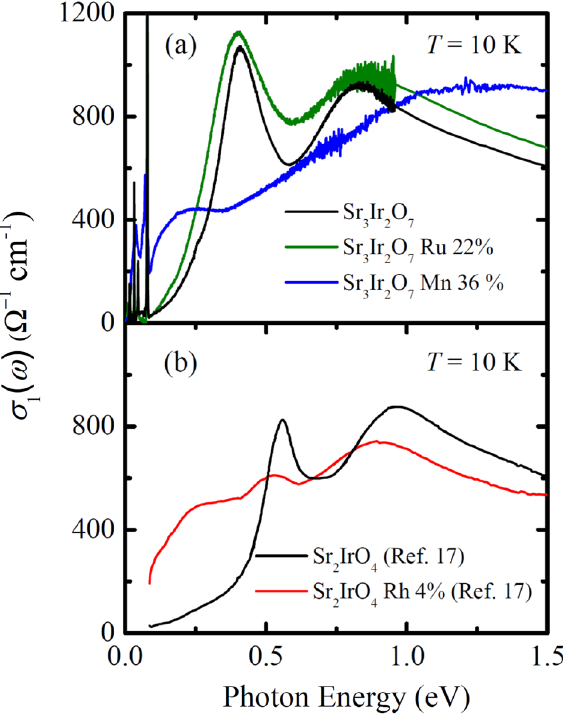
Figure 3. Optical conductivity spectra of ( a ) Sr 3 Ir 2 O 7 , Sr 3 (Ir 0.78 Ru 0.22 ) 2 O 7 , Sr 3 (Ir 0.64 Mn 0.36 ) 2 O 7 and ( b )